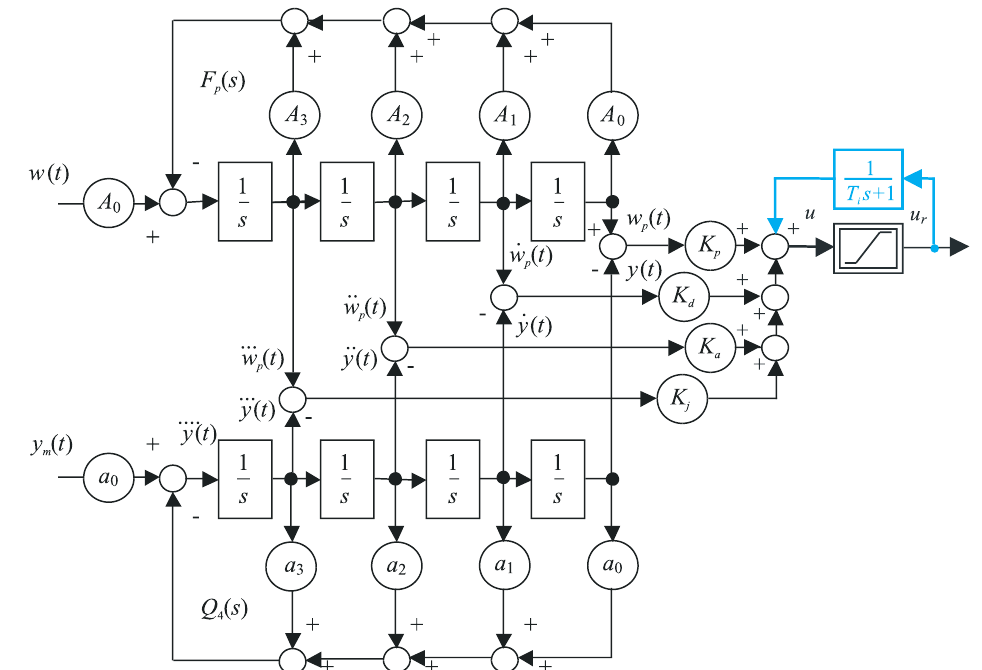
Figure 3. Series PIDAJ controller (34) with two degrees of freedom: the fourth-order filter Q 4 ( s ) (1) of the measured output y m ( t ) , the automatic-reset with time constant T i (blue), with proportional, derivative, accelerative and jerk controller gains K p , K d , K a and K j , with the reference setpoint w ( t ) and a fourth-order prefilter F p ( s )